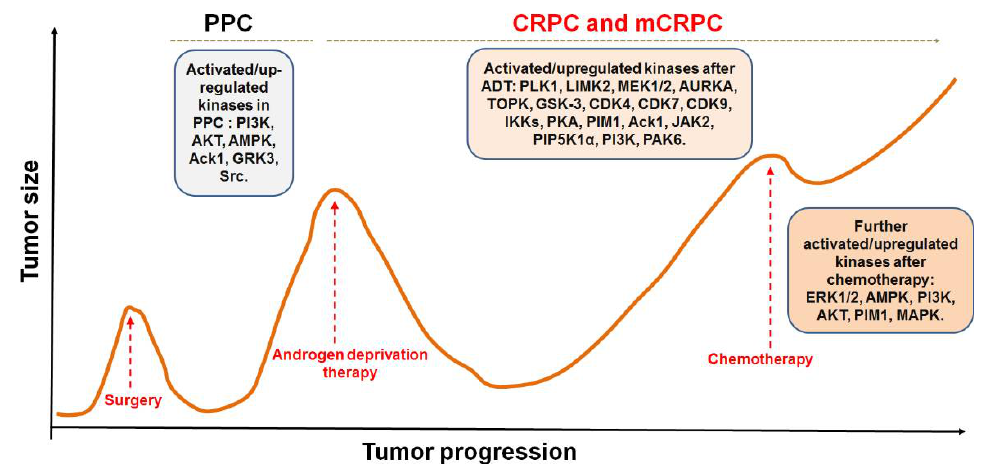
Figure 1. Diagram of prostate cancer progression and the activated/up-regulated kinases in primary prostate cancer (PPC), castration-resistant prostate cancer (CRPC), and metastatic CRPC (mCRPC).